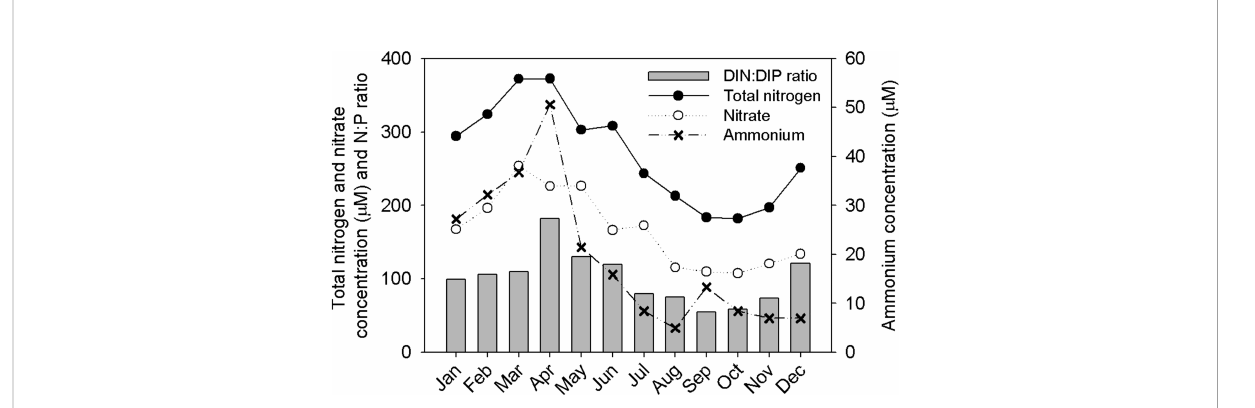
FIGURE 2 Monthly concentration variations in total nitrogen, inorganic nitrogen, and DIN:DIP ratios near the inside of the dam (Yeongsan Lake; St. 1), obtained from the National Institute of Environmental Research (http://water.nier.go.kr).